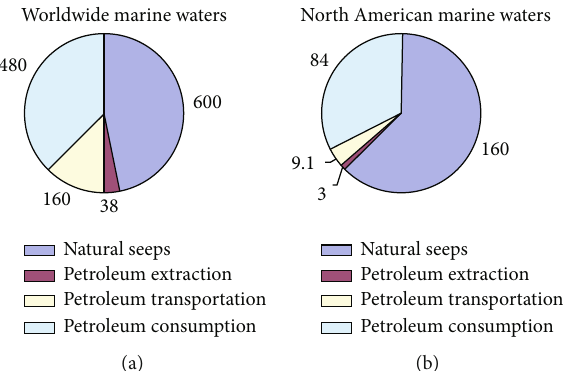
Figure 1: Contribution of average annual oil releases (in ktonnes) for 1990-1999 for (a) the globe and (b) North America. From NRC